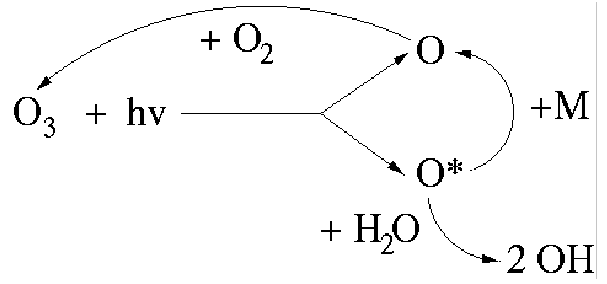
1 Fig. 2. Production of OH via photolysis of ozone. The photolysis of ozone (O 3 ) produces oxygen atoms in a ground state (O) or higher energy state (O*); the latter can react with water vapour to produce 2OH radicals. Some of the higher energy state oxygen atoms are quenched back to the ground state. The ground state atoms reform